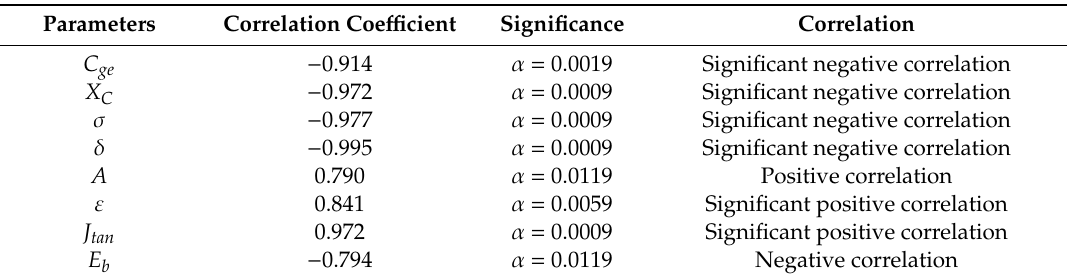
Table 7. Correlation between lifespan prediction parameters and aging